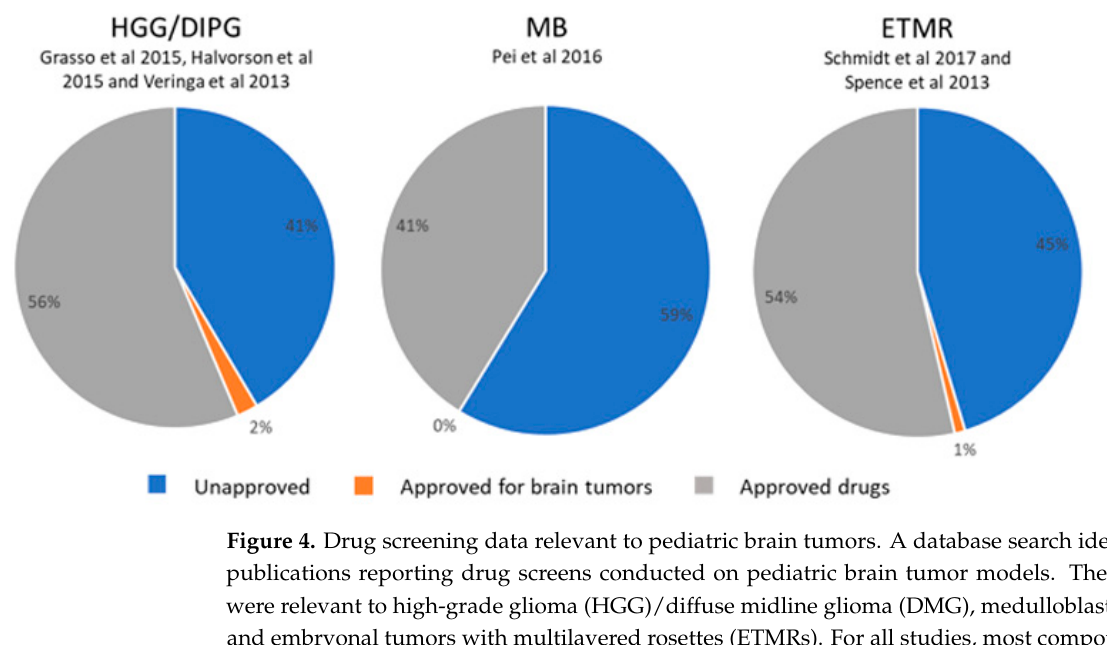
Figure 4. Drug screening data relevant to pediatric brain tumors. A database search identified six publications reporting drug screens conducted on pediatric brain tumor models. These screens were relevant to high-grade glioma (HGG)/diffuse midline glioma (DMG), medulloblastoma (MB) and embryonal tumors with multilayered rosettes (ETMRs). For all studies, most compounds used in the screens were either already approved (41–56% of drugs) or unapproved (41–59% of drugs), suggesting that almost half of drugs tested could be repurposed (original figure)